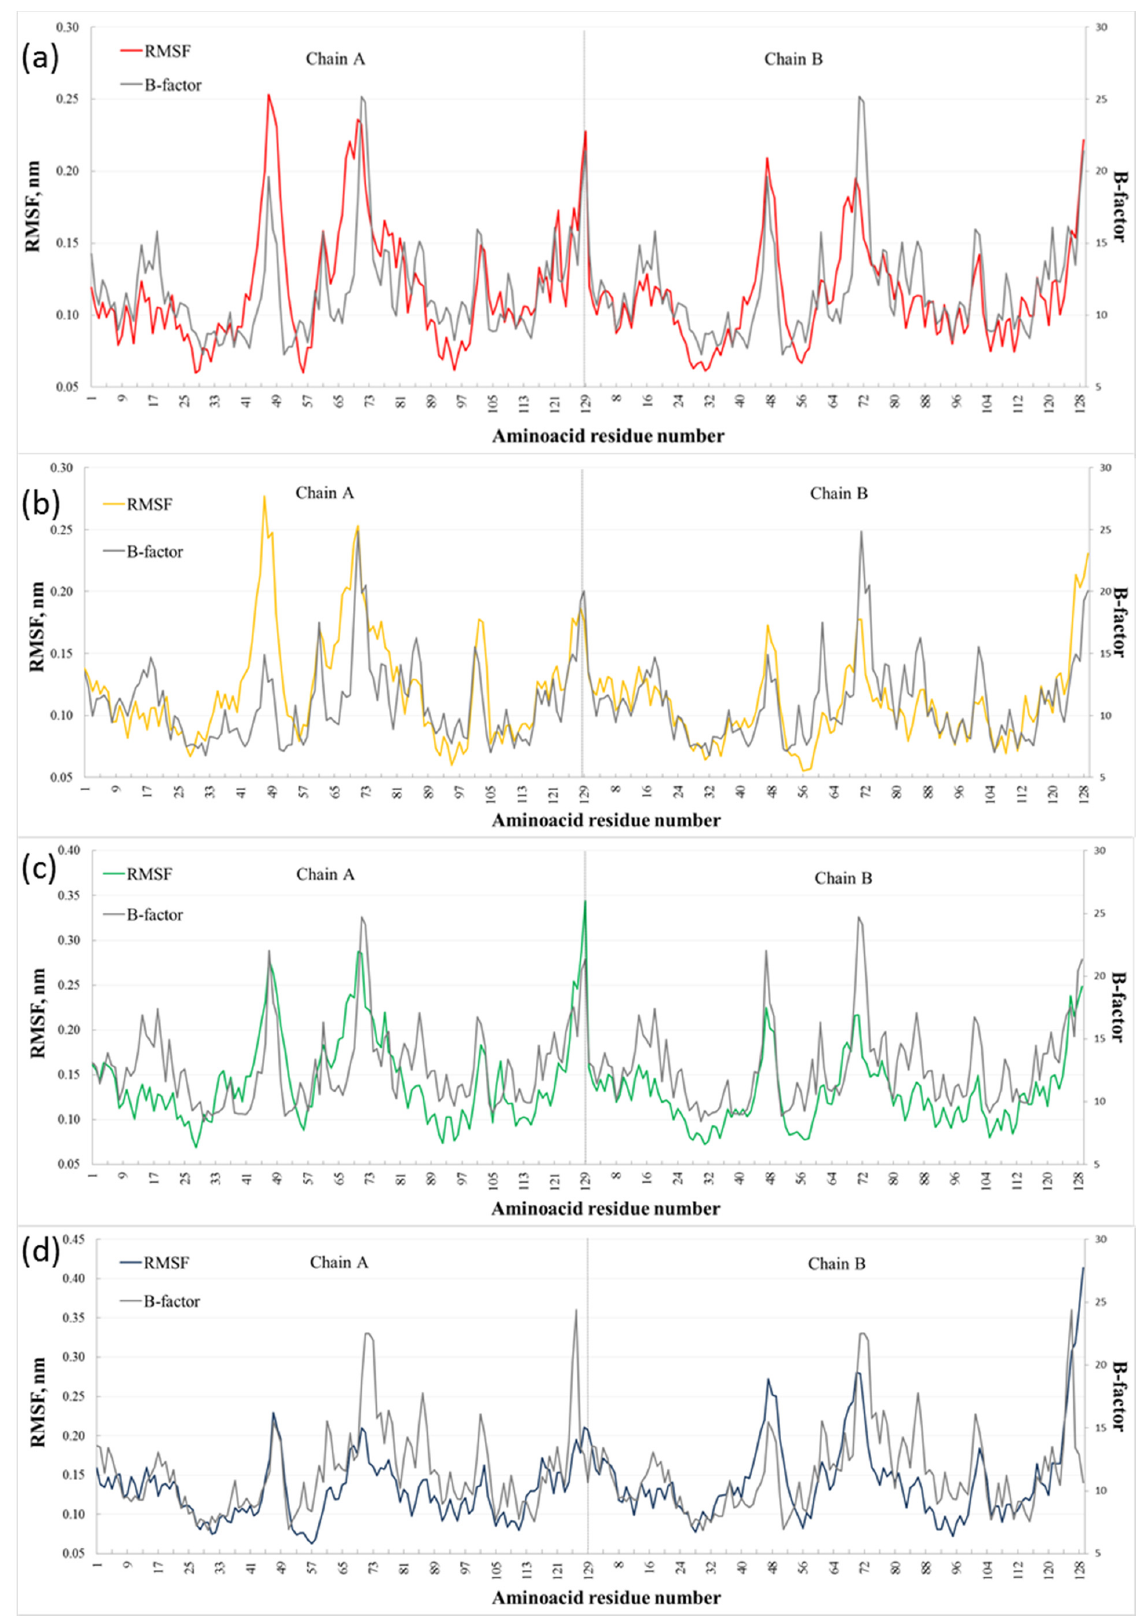
Figure 8. Comparison of the temperature B-factor with the RMSF of dimers with different precipitants: LiCl ( a ), NaCl ( b ), KCl ( c ) and CuCl 2 ( d ). Chains A and B are the polypeptide chains of dimers.